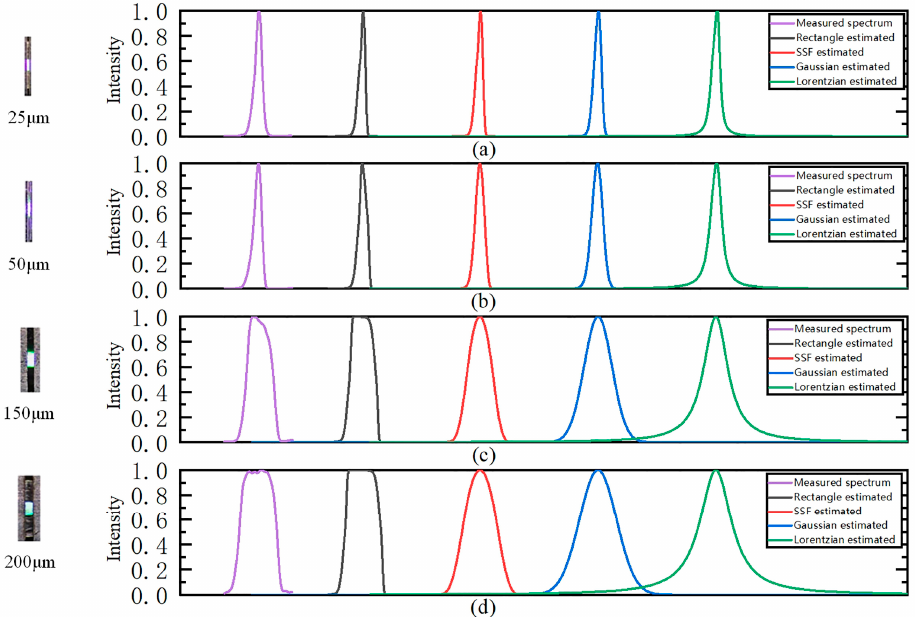
Figure 4. Measured and simulated wavelength distribution of 696.543 nm at f slit width of ( a ) 25 µ m, ( b ) 50 µ m, ( c ) 150 µ m, and ( d ) 200 µ m.